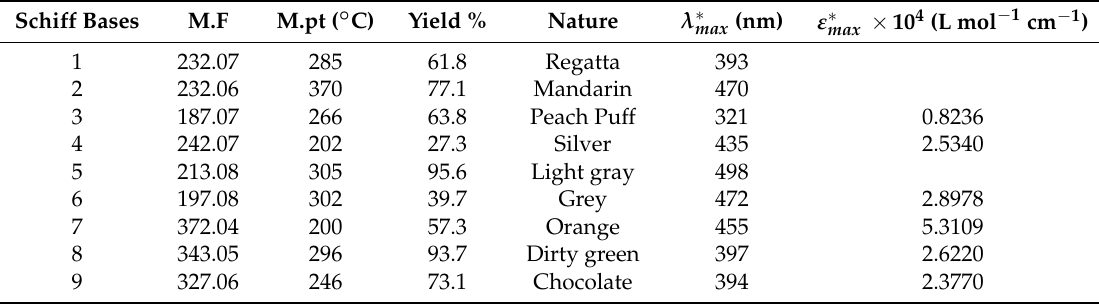
Table 1. Physio-parameters and UV-Visible data of Schiff bases ( 1 – 9 ).